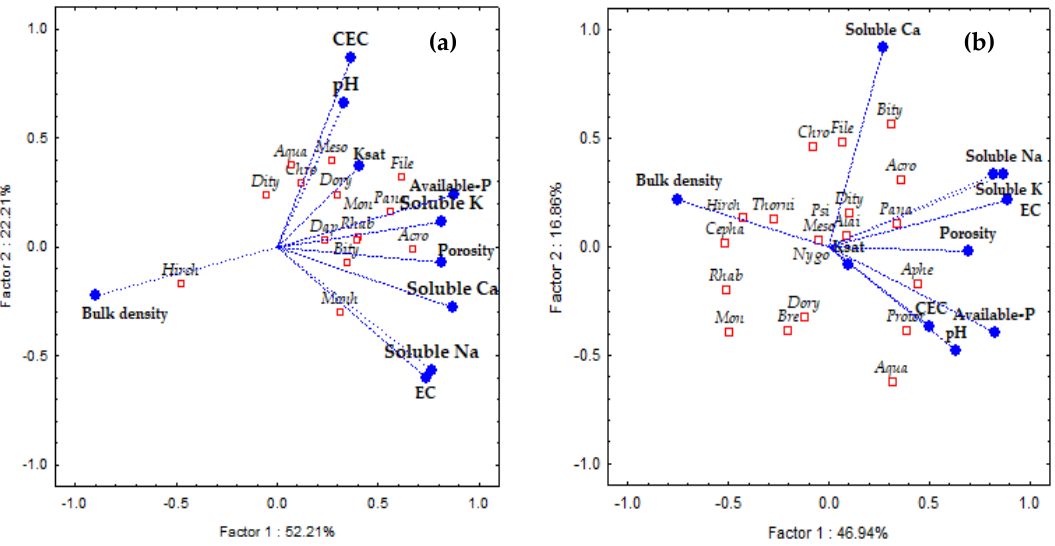
Figure 7. The principal components analysis (PCA) based on abundance of nematode community and soil physicochemical properties in acid sulfate soil ( a ) and alluvial soil ( b ). The physicochemical properties have been reported by Phuong et al. [47]. The abbreviation names of nematode taxa have been mentioned in the supplementary material.